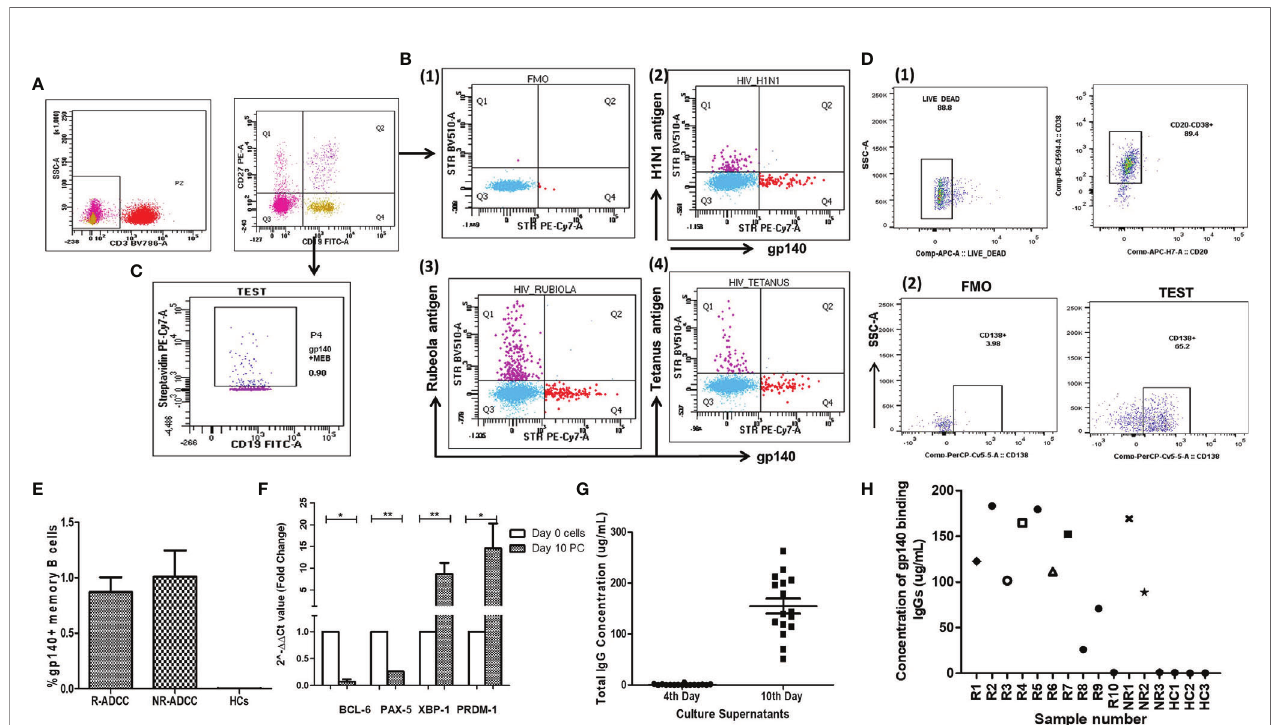
FIGURE 2 | Generation of HIV-speci fi c antibodies from HIV-speci fi c memory B cells. (A) The dot plots show the gating strategy used to identify gp140+ memory B cells. The CD3 − cells were gated from the lymphocytes which were then drilled down to gate CD3 − CD19+CD27+ memory B cells. (B) To assess the binding speci fi city of the gp140 probe to a speci fi c BCR, the PBMCs were co-stained with an HIV-gp140 protein probe and one of the three non-HIV antigen probes. The antigen-speci fi c memory B cells were gated from CD3 − CD19+CD27+ memory B cells. Subpanel (B1) represents the fl uorescence minus one (FMO) control and subpanels (B2-B4) represent the dot plots showing the cells stained by biotinylated HIV-1 gp140 probe-conjugated with streptavidin PE-Cy7 ( X -axis in all) and the streptavidin BV510 tagged biotinylated antigens, viz., H1N1 antigen, Rubeola antigen, and tetanus antigen, respectively ( Y -axis). (C) From the CD3 − CD19+CD27+ memory B cells, the gp140+ memory B cells were identi fi ed as CD3 − CD19+CD27+gp140+ memory B cells. (D) The dot plots show the gating strategy used for plasma cells. 1) The live cells were gated from lymphocytes which were further drilled down to gate CD20 − CD38+ plasmablast cells. 2) Further from these cells, plasma cells were gated as CD20 − CD38+CD138+ cells (right panel) using FMO control. (E) The bar diagram depicts the frequencies of gp140-speci fi c memory B cells ( Y -axis) in R-ADCC LTNPs ( n = 10), NR-ADCC LTNPs ( n = 3), and HCs ( n = 3) ( X -axis) at the initiation of culture. (F) The cells at day 0 and day 10 of culture were analyzed for the expression of TFs of BCL-6 , PAX-5 , XBP-1 , and PRDM-1 genes using real-time PCR. The expression levels of mRNA were normalized with b -actin and fold change ( DD CT) (plotted on the Y -axis) was calculated with the expression of the respective genes at day 0 as baseline. The data represent the mean expression level from eight samples. The error bar indicates the standard error of the mean. (G) The scattered plot shows the concentrations of IgGs ( m g/ml) ( Y -axis) in the supernatants collected on the 4th and 10th day of culture ( X -axis). (H) The concentration of gp140-binding antibodies (µg/ml) ( Y -axis) generated from the gp140+ memory B cells of R-ADCC LTNPs (R1 to R10), NR-ADCC LTNPs (NR1 to NR3), and HIV-negative individuals ( X -axis). The * represents P ≤ 0.05 and ** represents P ≤